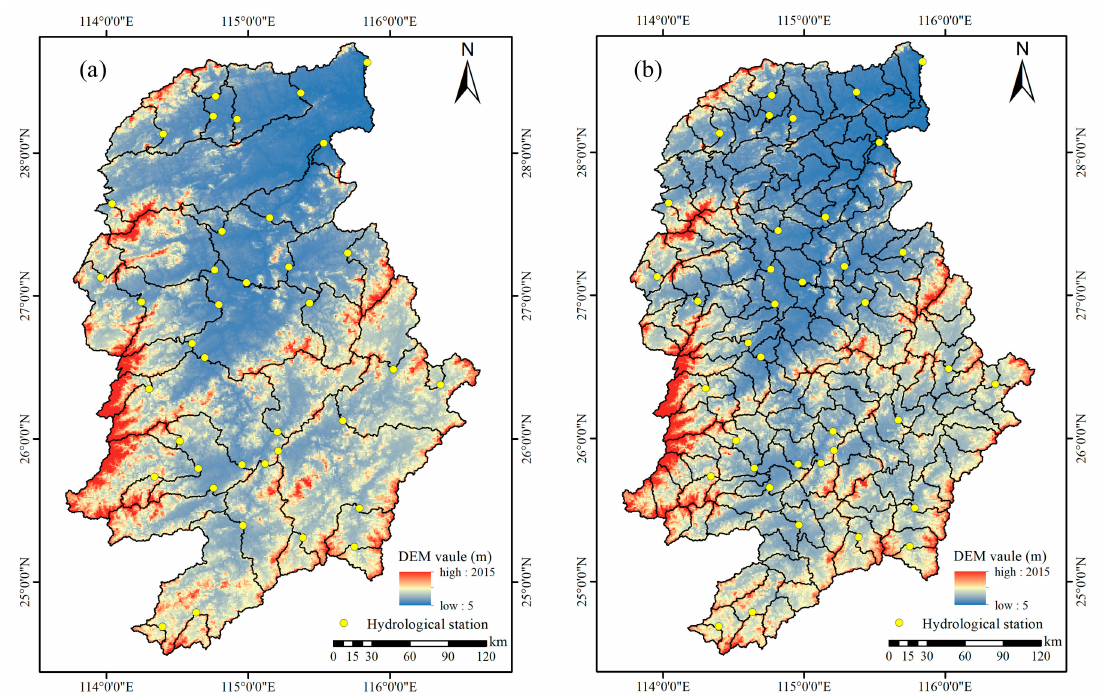
Figure 2. Results of small-scale basin division in the Ganjiang River Basin ( a ) the hydrological stations control layer, ( b ) the area control layer.